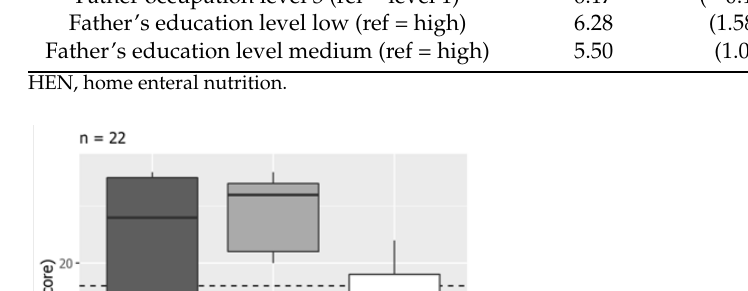
Table 4. Multiple Poisson regression model estimates for health-related quality of life score. Results for subgroup analysis (both parents as caregiver) .